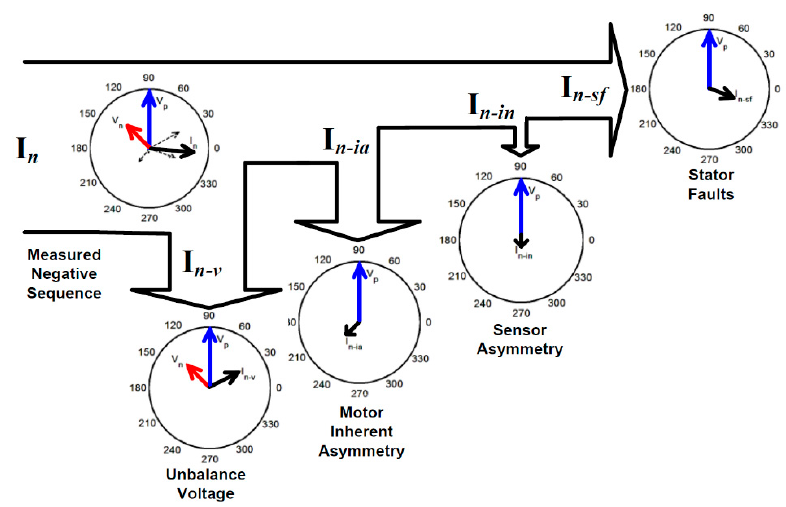
Figure 4. The compensation techniques using phasor calculations, where both the magnitude and the phase of the negative sequence current are illustrated to separate the stator faults.